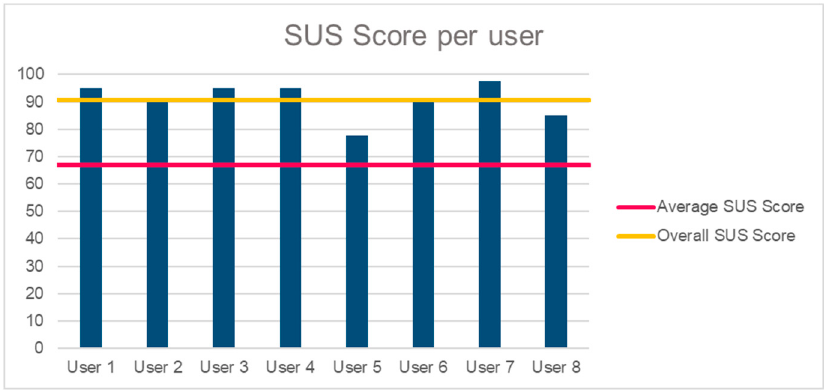
Figure 17. System Usability Scale (SUS) score per user for the mobile application of HypnOS.